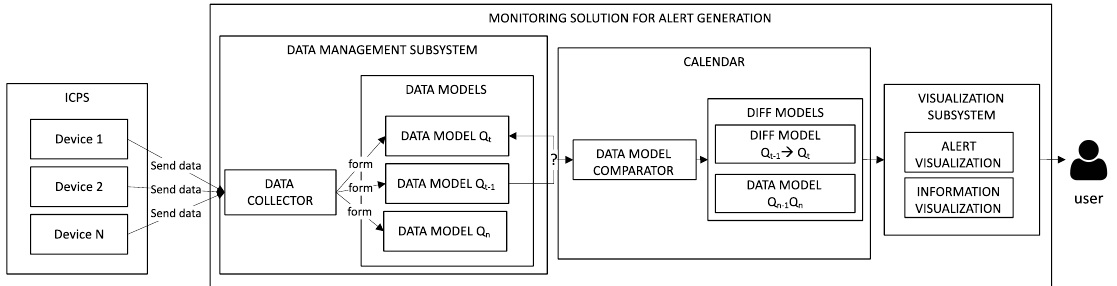
Figure 1. An overview of monitoring Industrial Cyber-Physical Systems (ICPSs): the captured data and detected evolution to alert